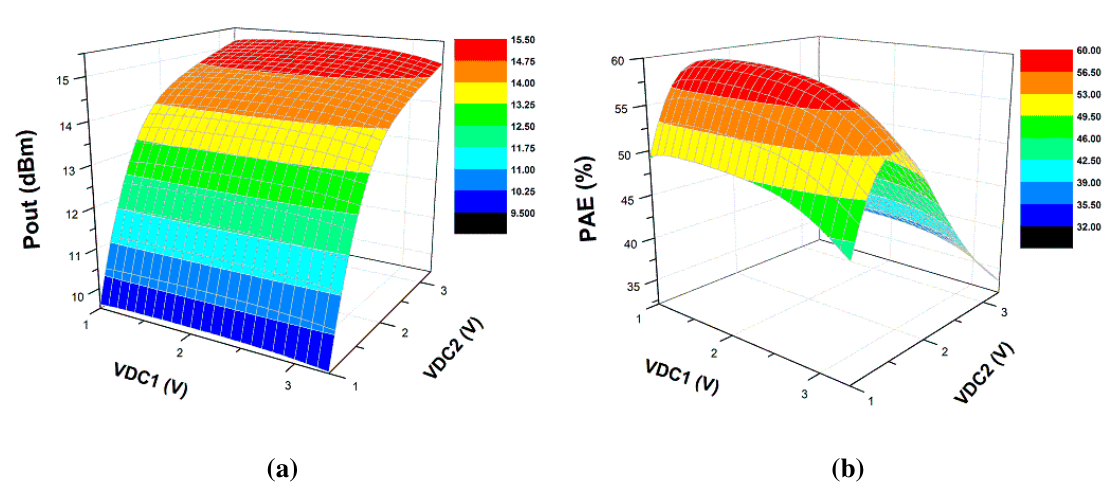
Figure 16. First-stage and second-stage supply voltages versus ( a ) output power; ( b ) power-added efficiency.